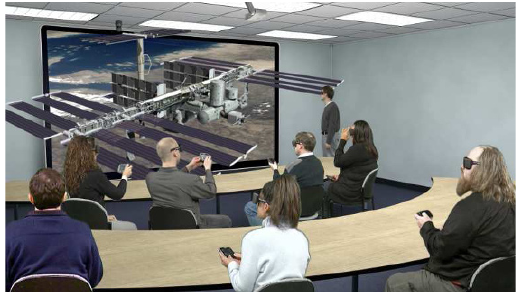
Figure 11. Interactive Immersive Classroom.